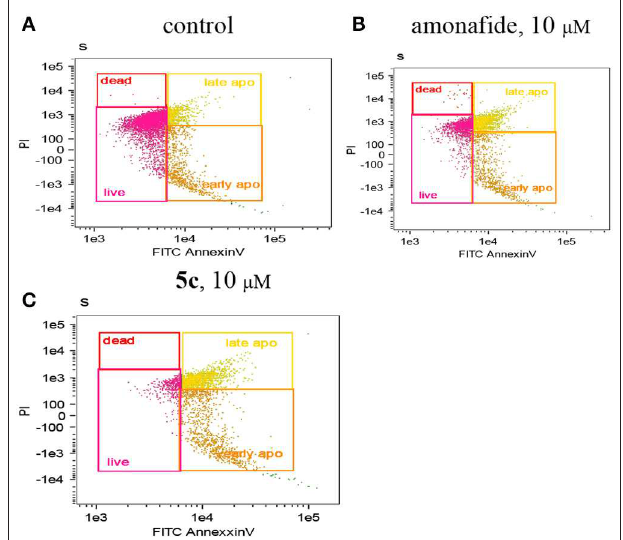
can be obtained from the in vitro biological results.